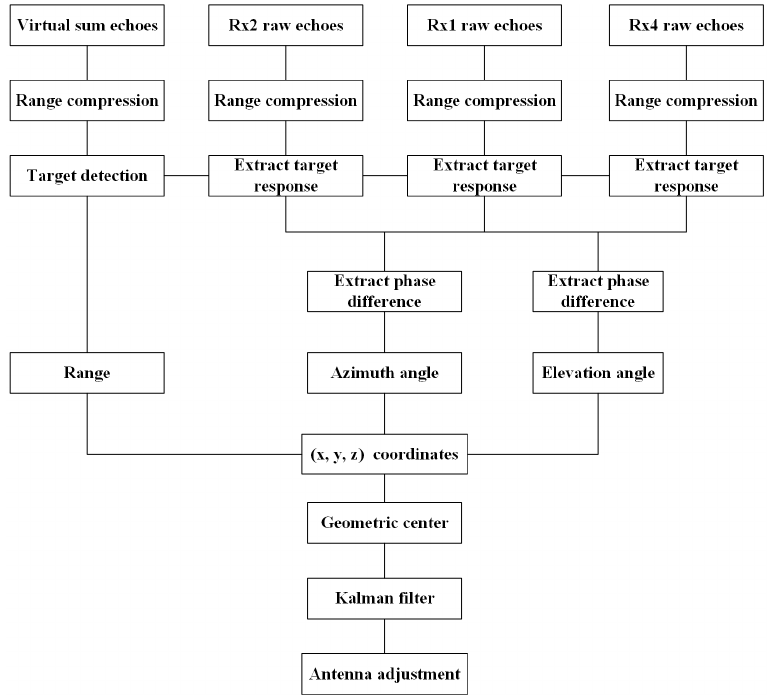
Figure 5. Flowchart of target locating and tracking with multiple beams. Table 1. Detailed procedures of the target locating and tracking.